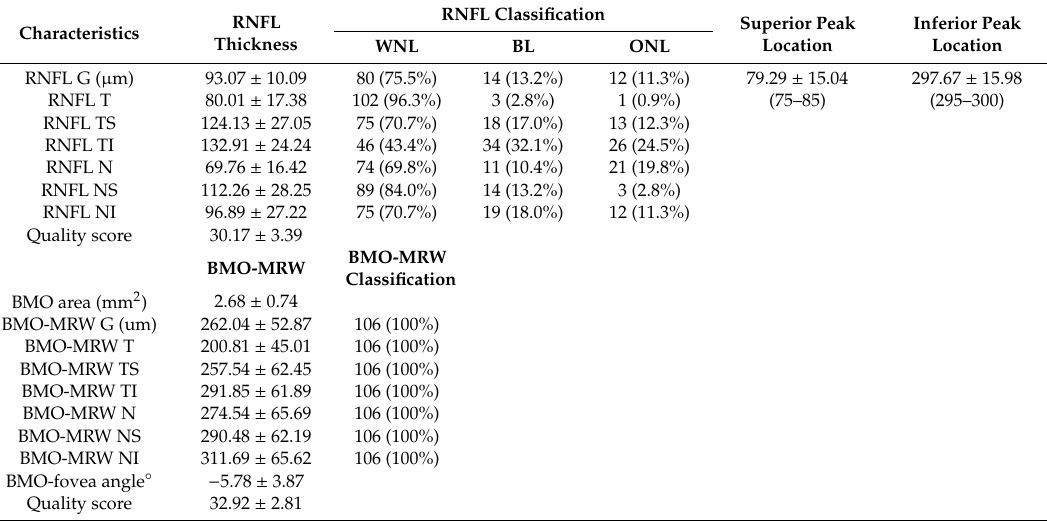
Table 3. Retinal nerve fiber layer and Bruch membrane opening minimum rim